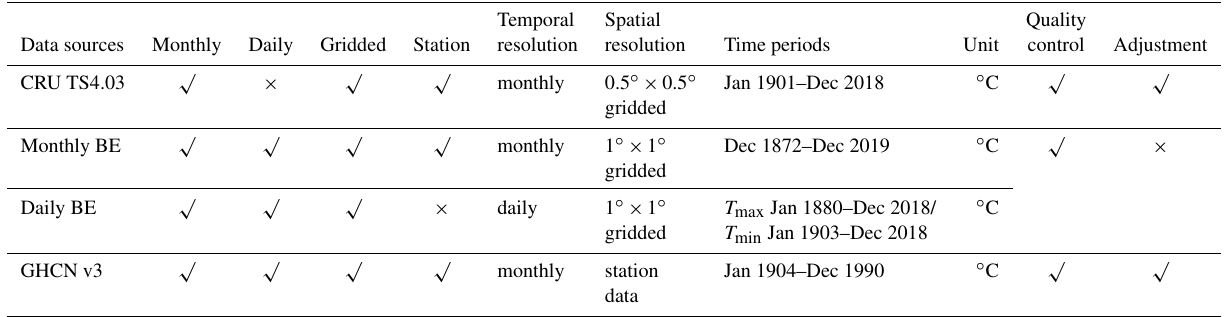
Table 2. Information on reference data